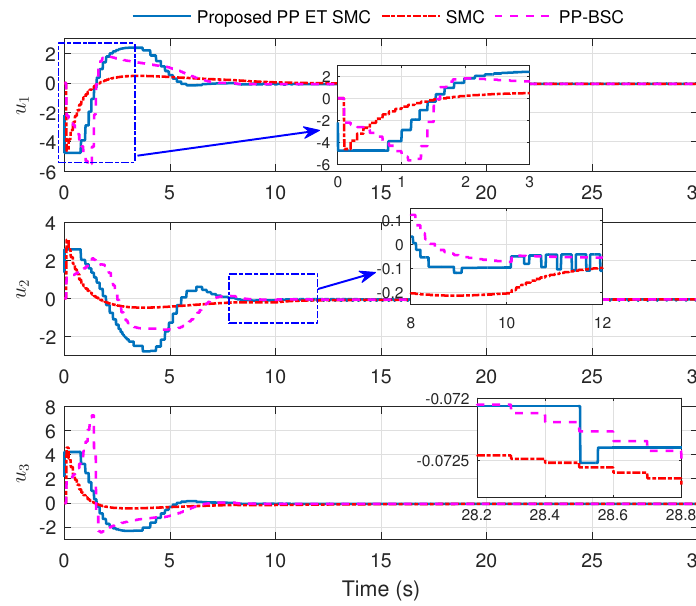
Figure 6. Control input